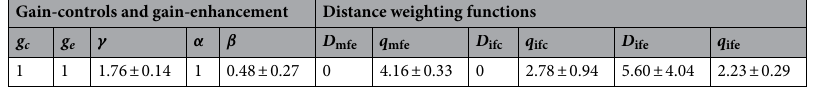
(Table 2). Without any flank-target interaction, the DS model (AM 1) fit the data very poorly with 0% likelihood. Inputting a flanker to the DS model as a weak pedestal (AM2 or wPed) even worsens the model performance.